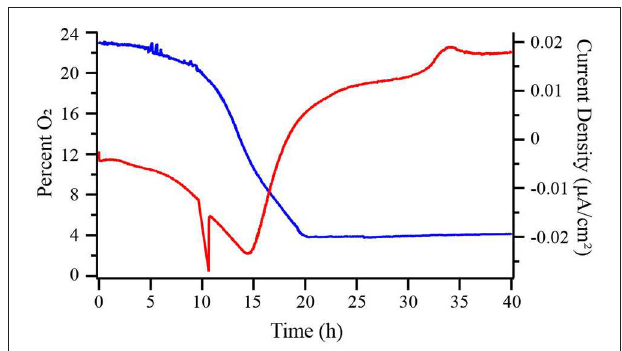
FIGURE 2 | Percent dissolved oxygen (DO) in the bulk medium (blue) and chronoamperometry (red) of a wild type (WT) M. atlanticus bioelectrochemical system (BES) with a carbon cloth working electrode poised at 310mV vs. SHE. Representative trace of duplicated experiments is